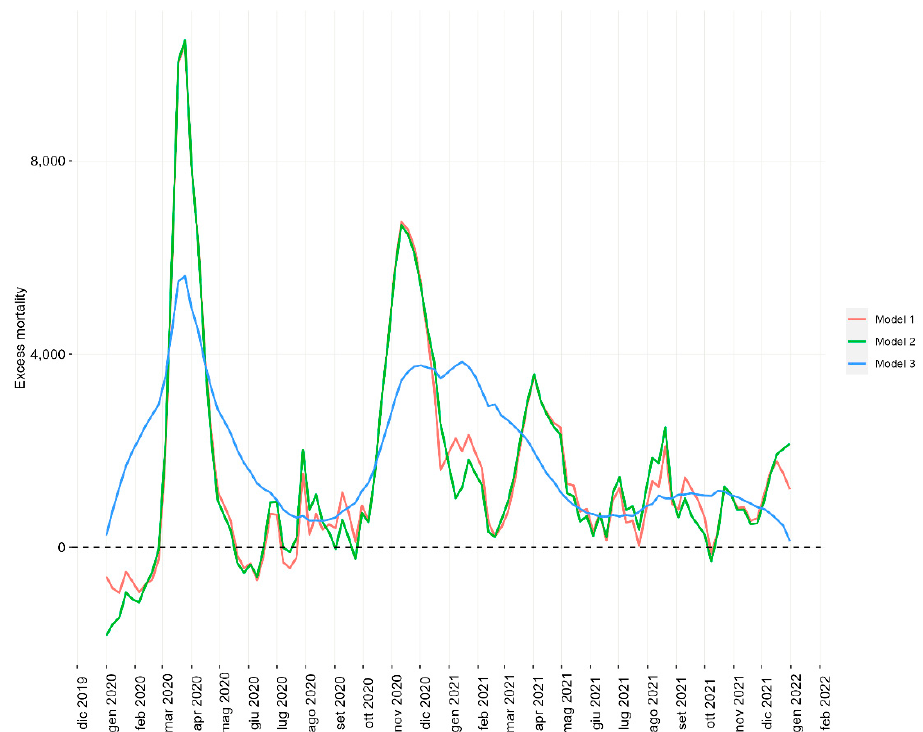
Figure 1. Weekly number of excess deaths estimated by the three models during 2020–2021 in